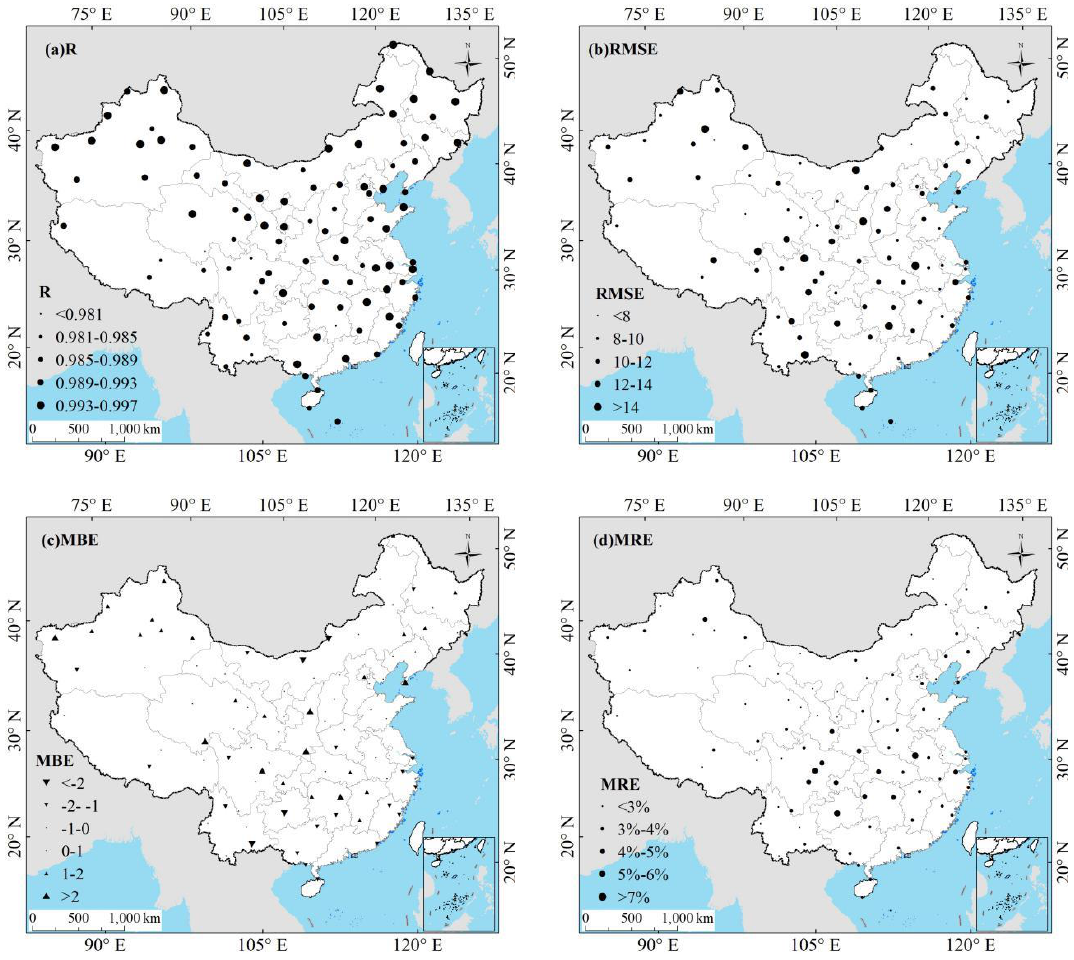
Figure 4. Spatial distribution of the ERT-based model performance on 96 CDC/CMA stations for ( a ) R, ( b ) RMSE, ( c ) mean bias error (MBE), and ( d ) mean relative error (MRE) during 2000–2015.